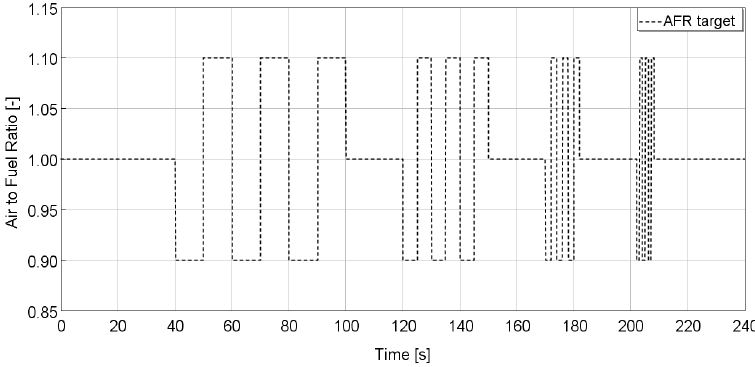
Figure 3. λ target in the dynamic experimental test.